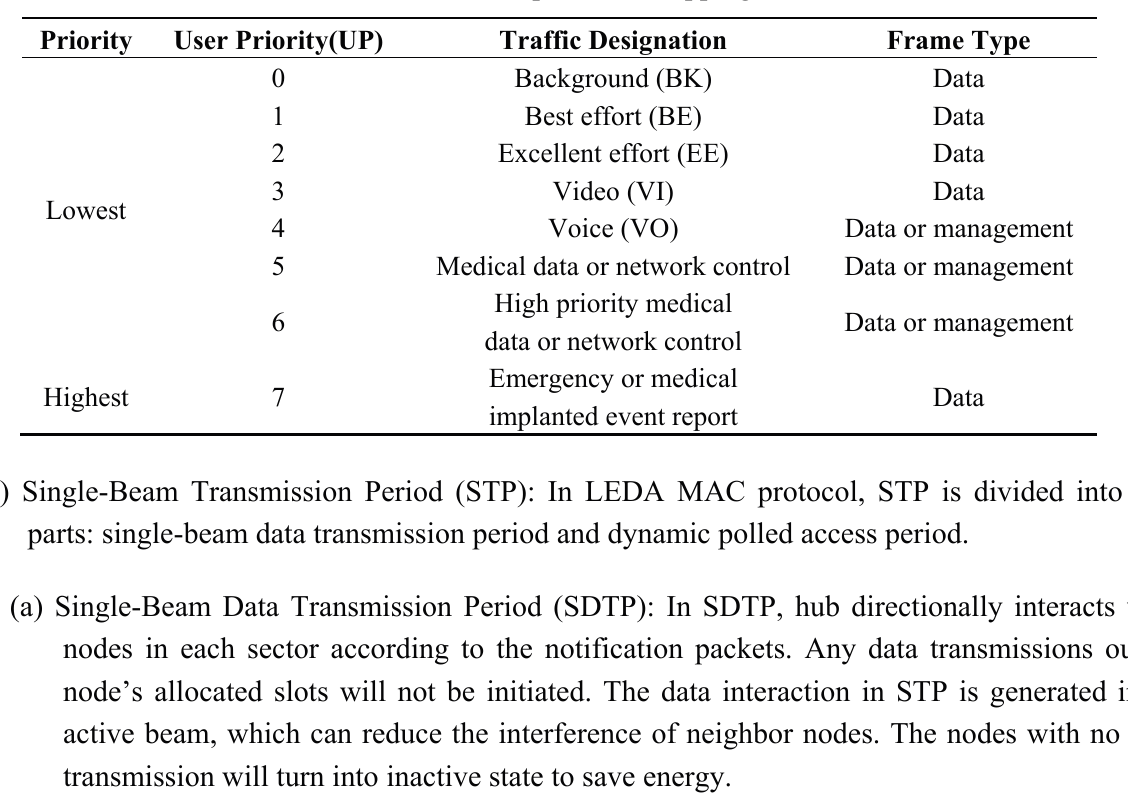
Table 1. User priorities